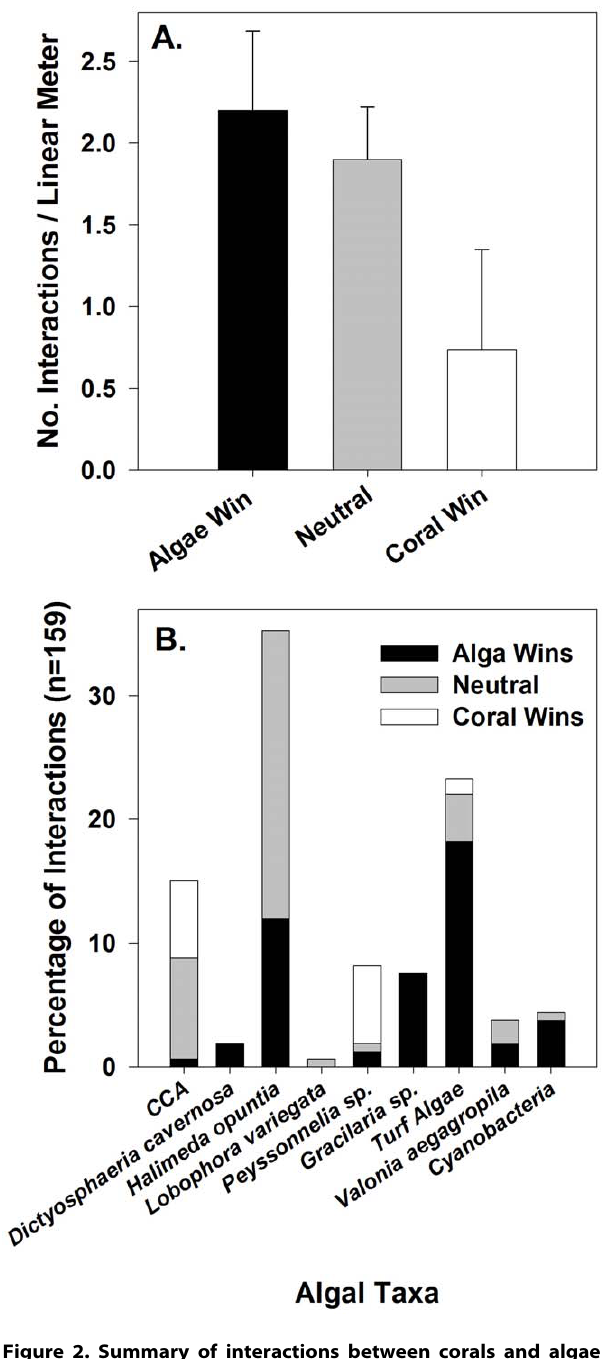
Figure 2. Summary of interactions between corals and algae from surveys of Millennium Atoll. A) Total number of interactions between corals and algae, B) outcome of coral-algal interactions by algal group.